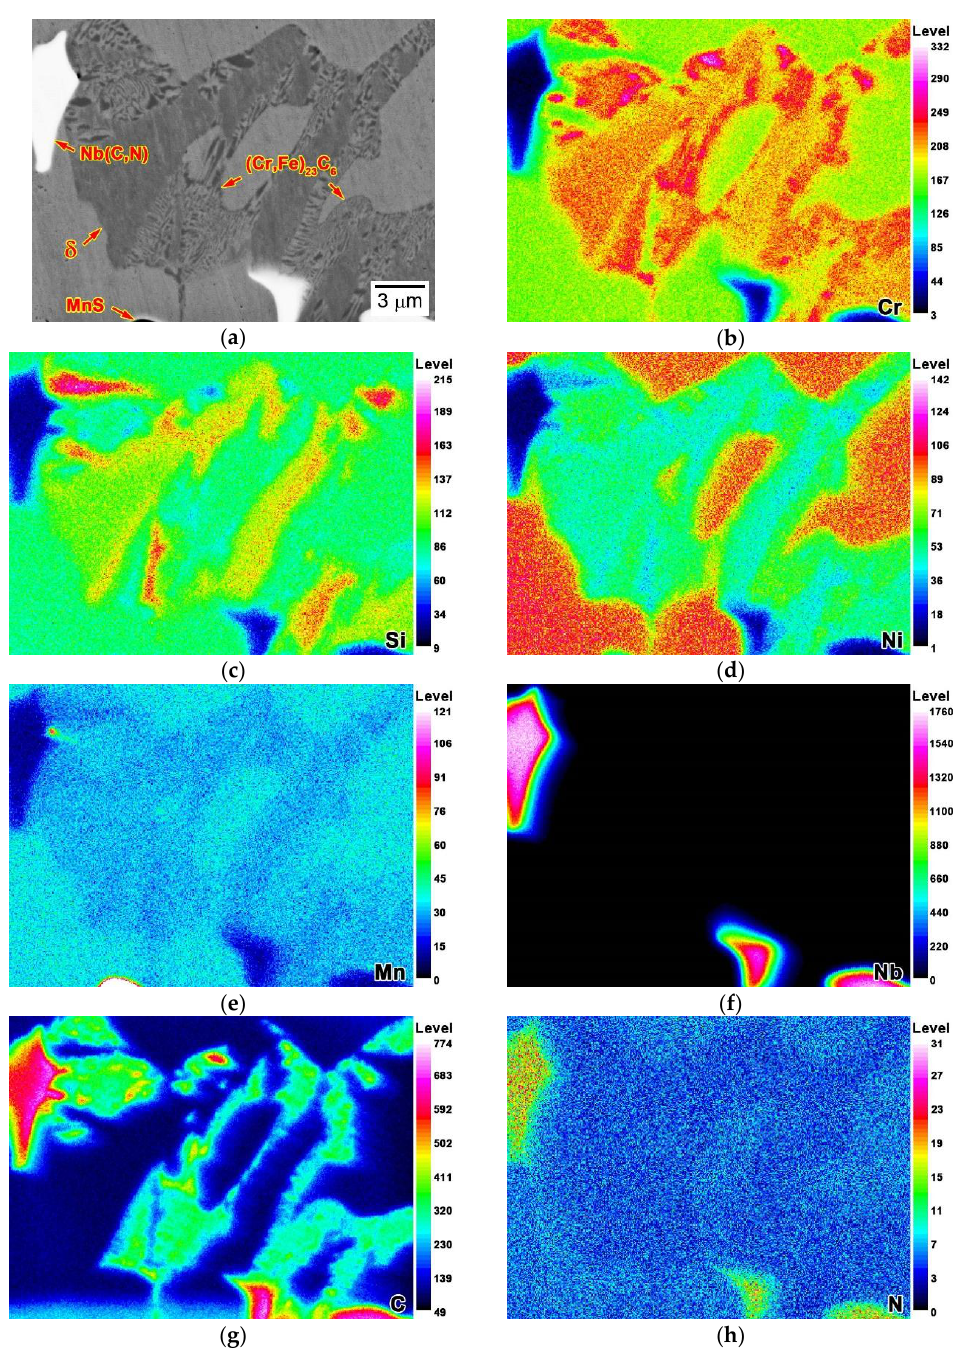
Figure 9. ( a ) EPMA-BSE image and compositional maps for ( b ) Cr, ( c ) Si, ( d ) Ni, ( e ) Mn, ( f ) Nb, ( g ) C, and ( h ) N of (Cr,Fe) 23 C 6 carbide and δ-ferrite taken at location III in Figure 6a.